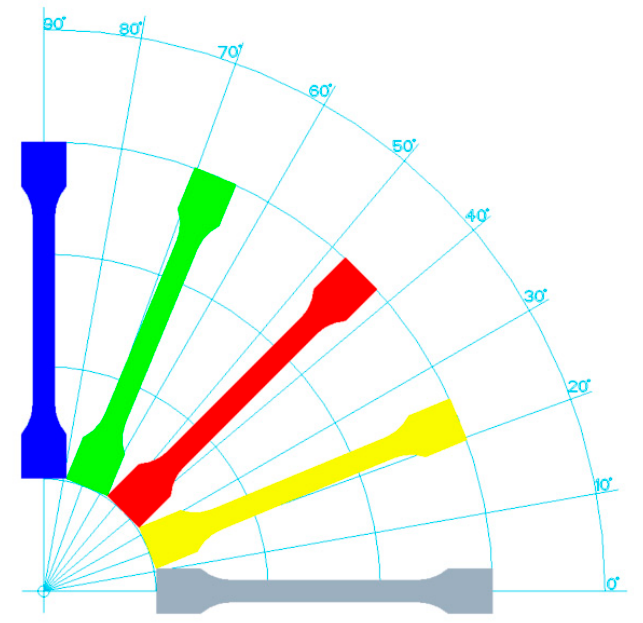
Figure 3. Position of the sample to be produced on the build table rotated around the Z -axis.